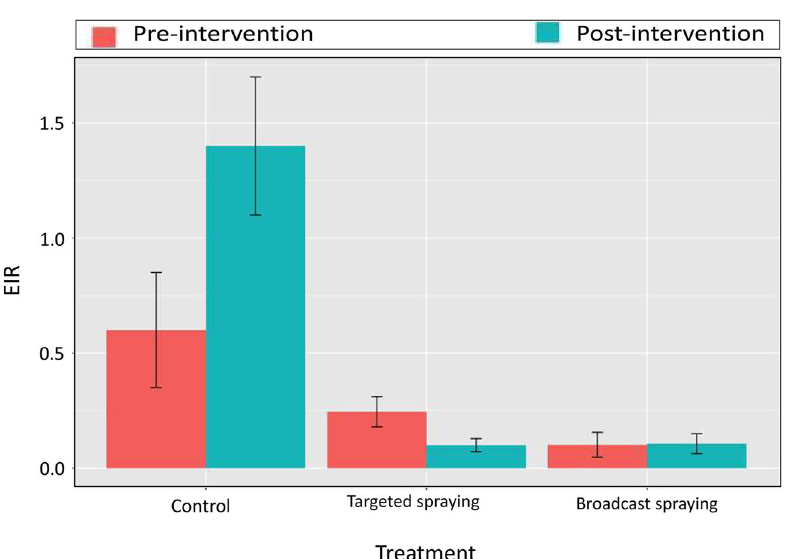
Figure 10. Variation of the Entomological Inoculation Rate (EIR) between intervention periods. A significant reduction was noted in treated villages by targeted spraying (P <